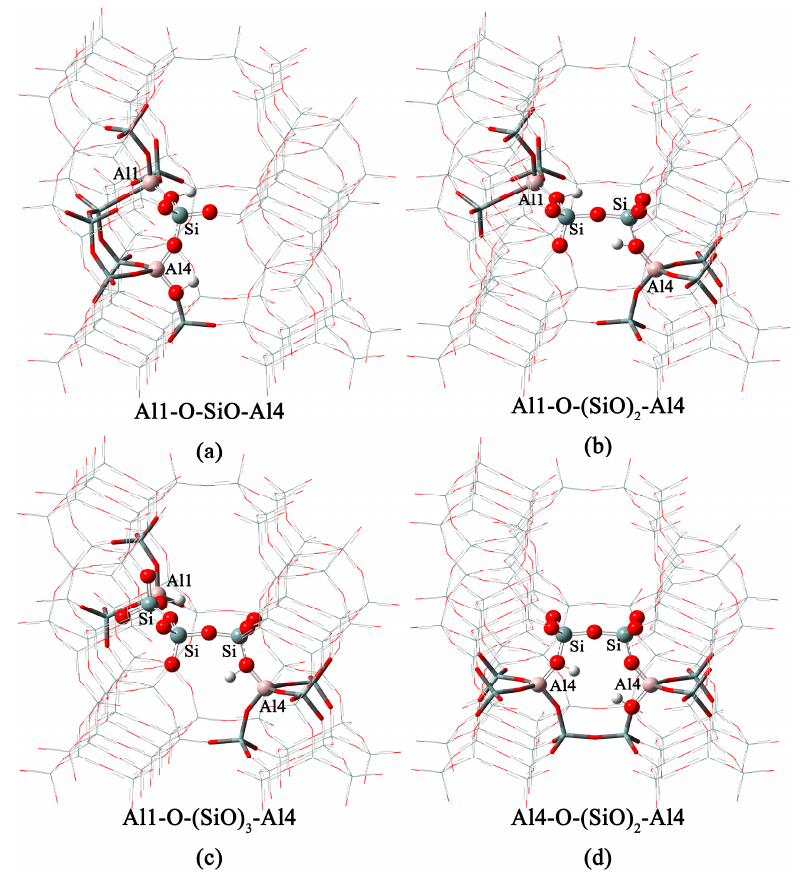
Figure 2. Four different geometrically optimized structures, which have a different number of SiO between Al atoms in 2 ‐ Al substitution models, are displayed. T1 and T4 sites are substituted in models ( a ), ( b ) and ( c ), and these models have different amounts of SiO groups between Al atoms. When there are two SiO between Al atoms, two T4 sites in the same 6 ‐ membered ring are also populated by Al and is shown in model ( d ). On the 90T model, the region depicted by balls and tubes was treated at high ‐ level and the rest was treated at low ‐ level.